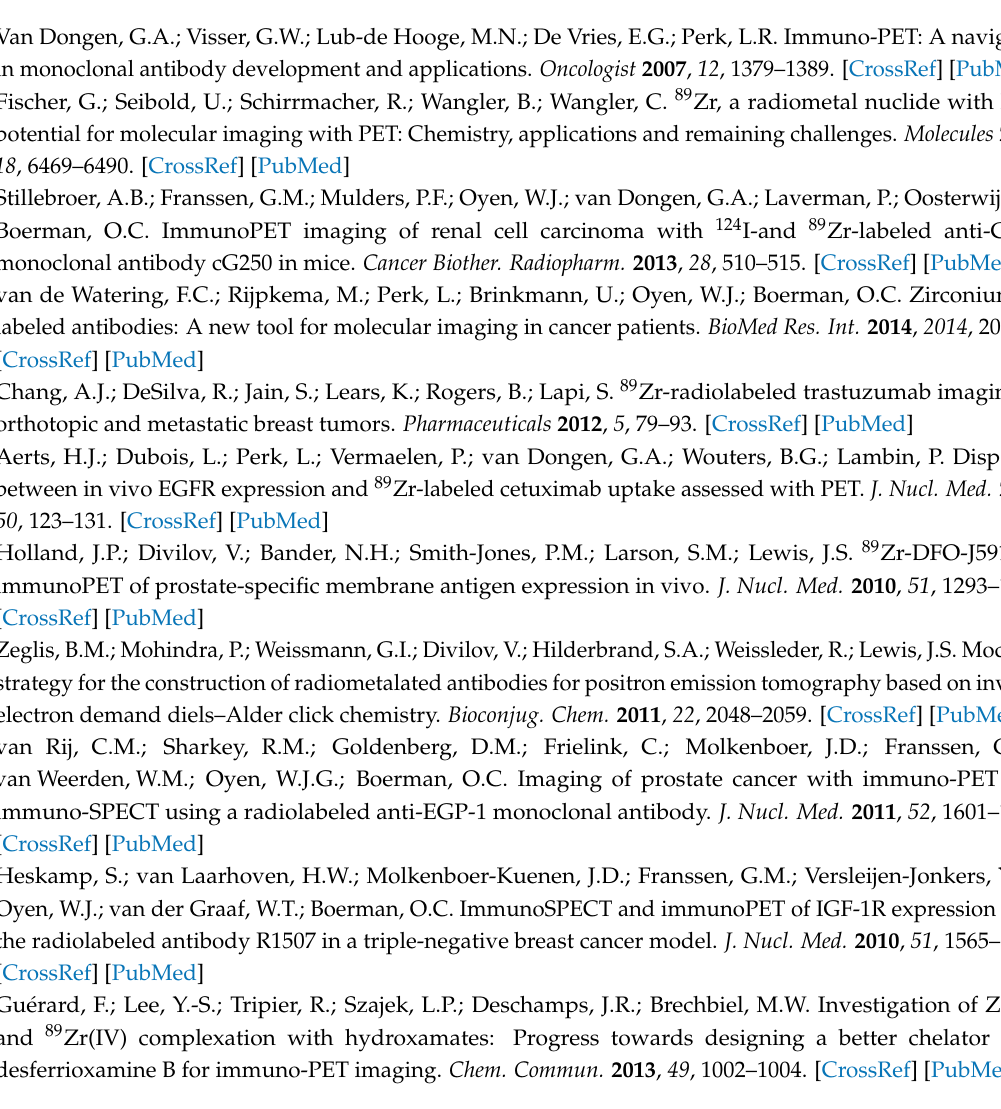
Figure S1: HPLC chromatogram of purified FSC(succ) 2 , Figure S2: HPLC chromatogram of purified FSC(succ) 2 AA, Figure S3: HPLC chromatogram of purified FSC(succ)3, Figure S4: The ESI-MS of [ nat Zr]FSC(succ) 3 , Figure S5: The ESI-MS of [ nat Zr]FSC(succ) 2 AA, Figure S6: The calculated isotope pattern for C 45 H 63 N 6 O 21 Zr ([ nat Zr]FSC(succ) 3 ), Figure S7: 3D microPET/CT images of [ 89 Zr]Zr-FSC(succ) 3 in a mouse 80min p.i., Figure S8: 3D microPET/CT images of [ 89 Zr]Zr-FSC(succ) 3 in a mouse 24h p.i., Figure S9: 3D microPET/CT images of [ 89 Zr]Zr-TAFC in a mouse 80min p.i., Figure S10 3D microPET/CT images of [ 89 Zr]Zr-TAFC in a mouse 24h